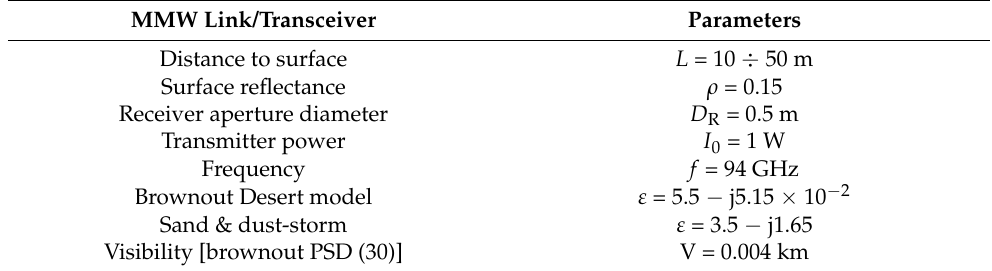
Table 6. Parameters for calculations.